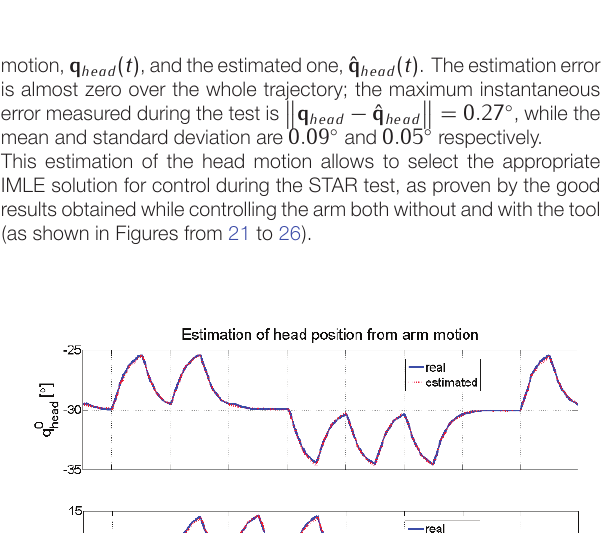
Figure 26. Arm joints positions with respect to time during the STAR test per- formed with the tool.